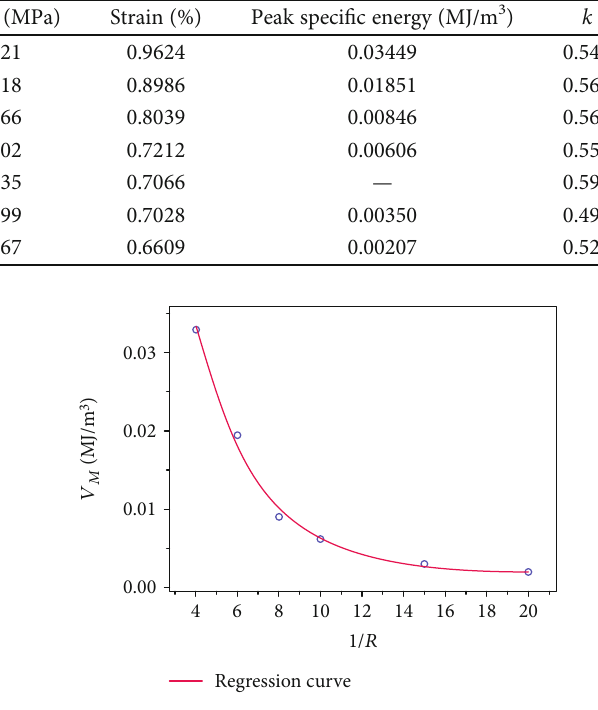
Figure 7: The relationship between the peak speci fi c energy of the back fi ll and the fi lling ratio. Table 3: Results of fi lling ratios of the back fi ll with di ff erent burial